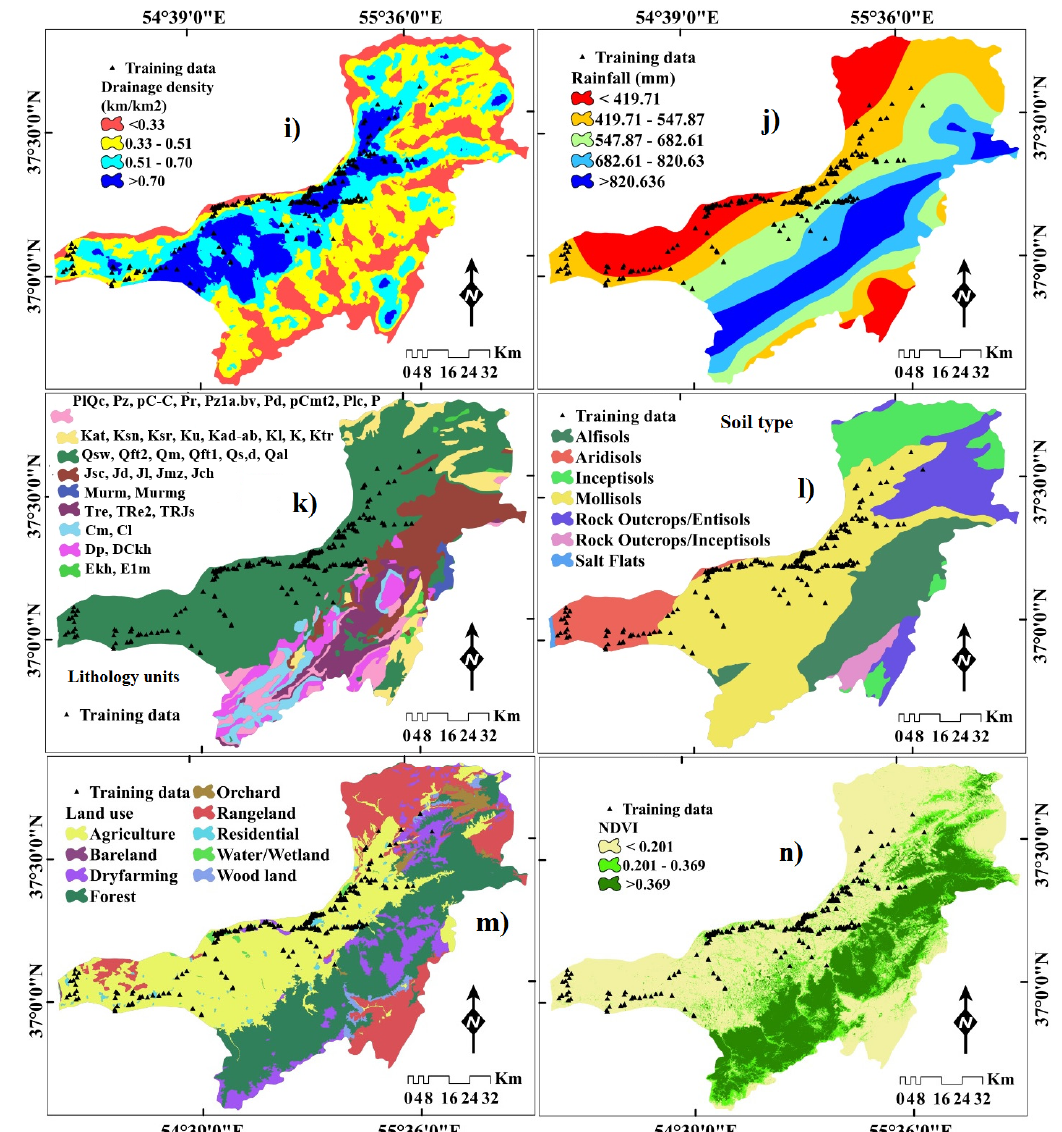
Figure 5. Flash flood conditioning factors, ( a ) slope ( b ) elevation, ( c ) plan curvature, ( d ) topographic wetness index (TWI), ( e ) topographic position index (TPI), ( f ) convergence index (CI), ( g ) stream power index (SPI), ( h ) distance to stream, ( i ) drainage density), ( j ) rainfall, ( k ) lithology, ( l ) soil type, ( m ) land use/land cover (LU/LC), ( n ) normalized difference vegetation index (NDVI).